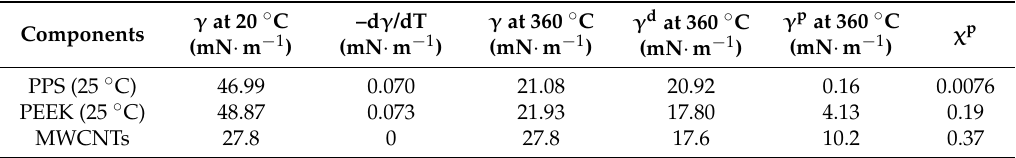
Table 2. Surface energy data for components of composites.